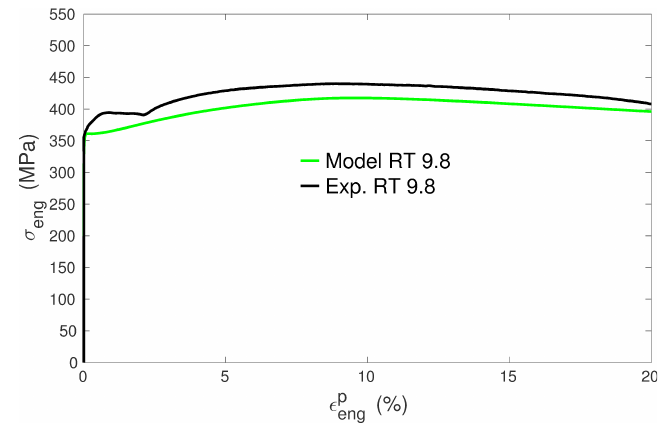
Figure 5. Tensile curves (engineering stress and strain) for model predictions and experimental measurements for the specimen deformed along the last transverse